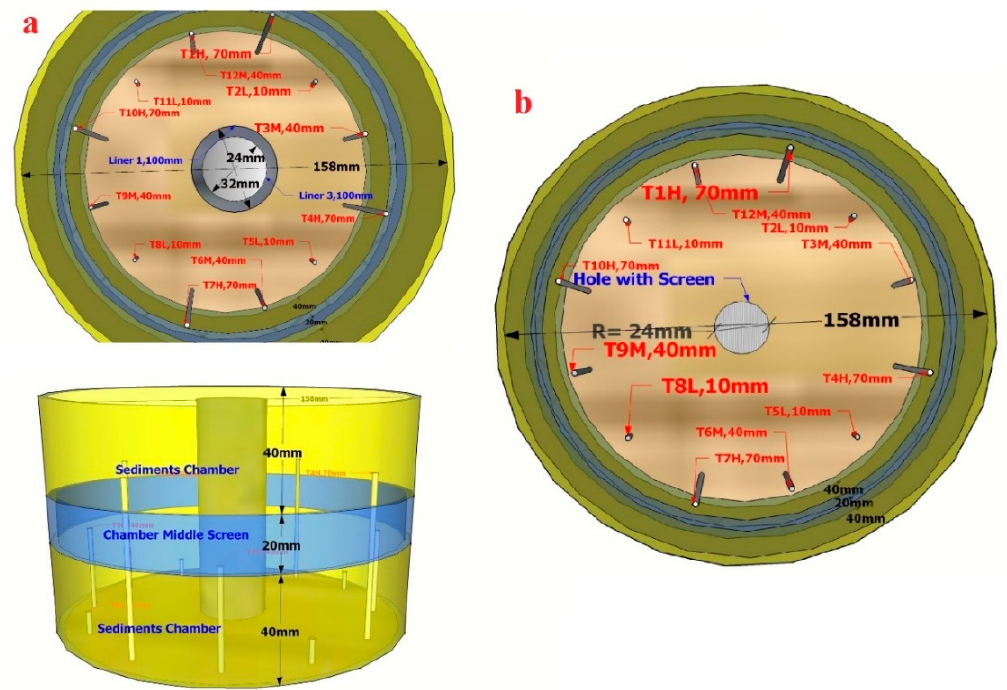
Figure 2. ( a ) Top and flat views of the sediment chamber in the vertical well [27]; ( b ) top view of the sediment chamber in the horizontal well. Each T is a temperature sensor, 1–12 displays their alignment; layers H, M, and L display the heights of the temperature sensors at 70, 40, and 10 mm, respectively.